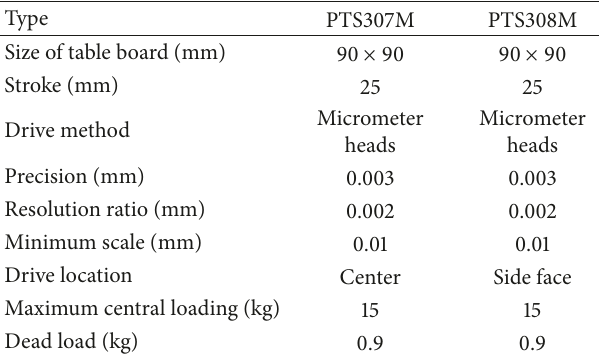
Table 4: Technical characteristics of PTS300 series displacement